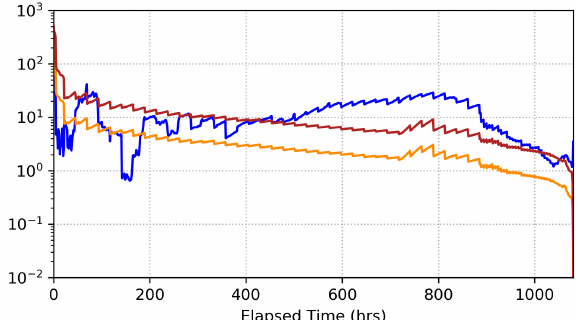
Figure 19. Position error (blue) and RTPC uncertainty (1- σ (orange) and 3- σ (red)) for fused filter with attitude thruster mis-modeling.